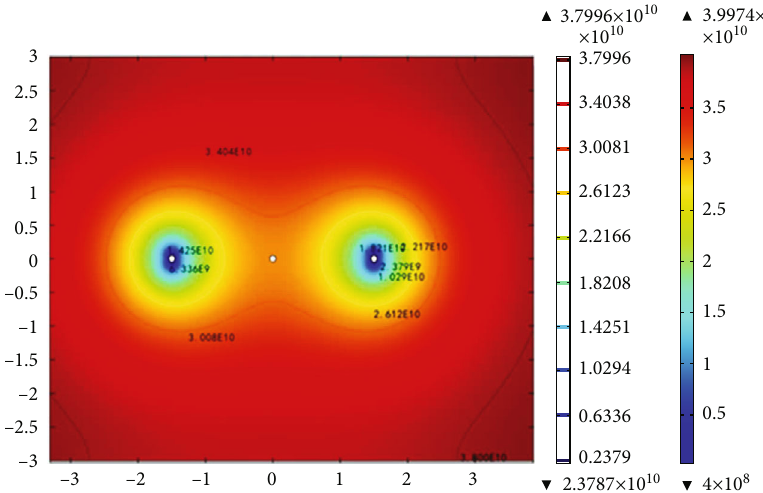
Figure 7: Gas pressure distribution around borehole after 180 days.